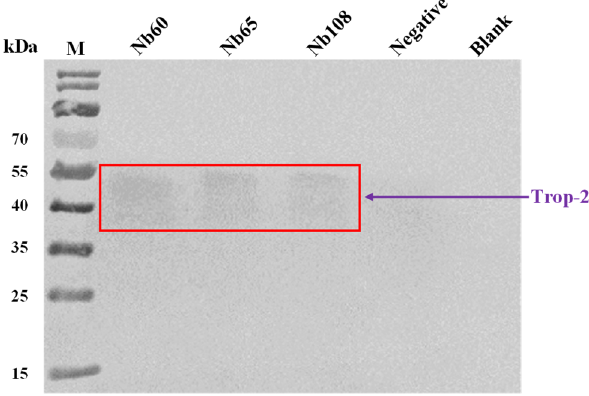
Figure 4. Immunoprecipitation of Trop-2 by Nbs. HCT116 cell lysates were collected and incubated with Nbs for capturing of Trop-2 protein. The protein A/G-coated agarose beads that were conjugated with anti-HA-tag IgG were used to precipitate the complex of Nb and Trop-2. The pellets were subjected to separation by SDS-PAGE and analysis by Western blot. Native Trop-2 was detected with mouse anti-Trop-2 IgG and HRP-conjugated anti-mouse IgG. Immunoprecipitation with mouse anti ‐ HA ‐ tag IgG instead of Nb was used as a negative control. Immunoprecipitation without any antibody was used as a blank control.